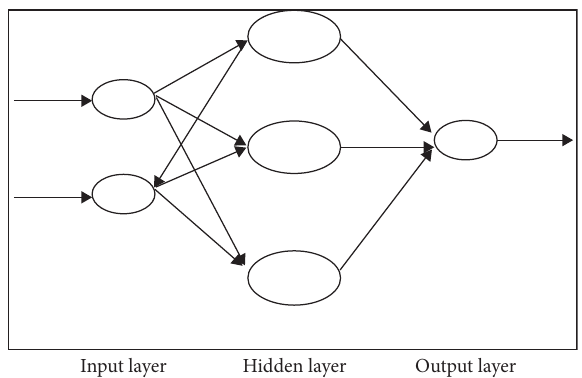
Figure 3: Schematic diagram of the three-layer BP neural network structure.